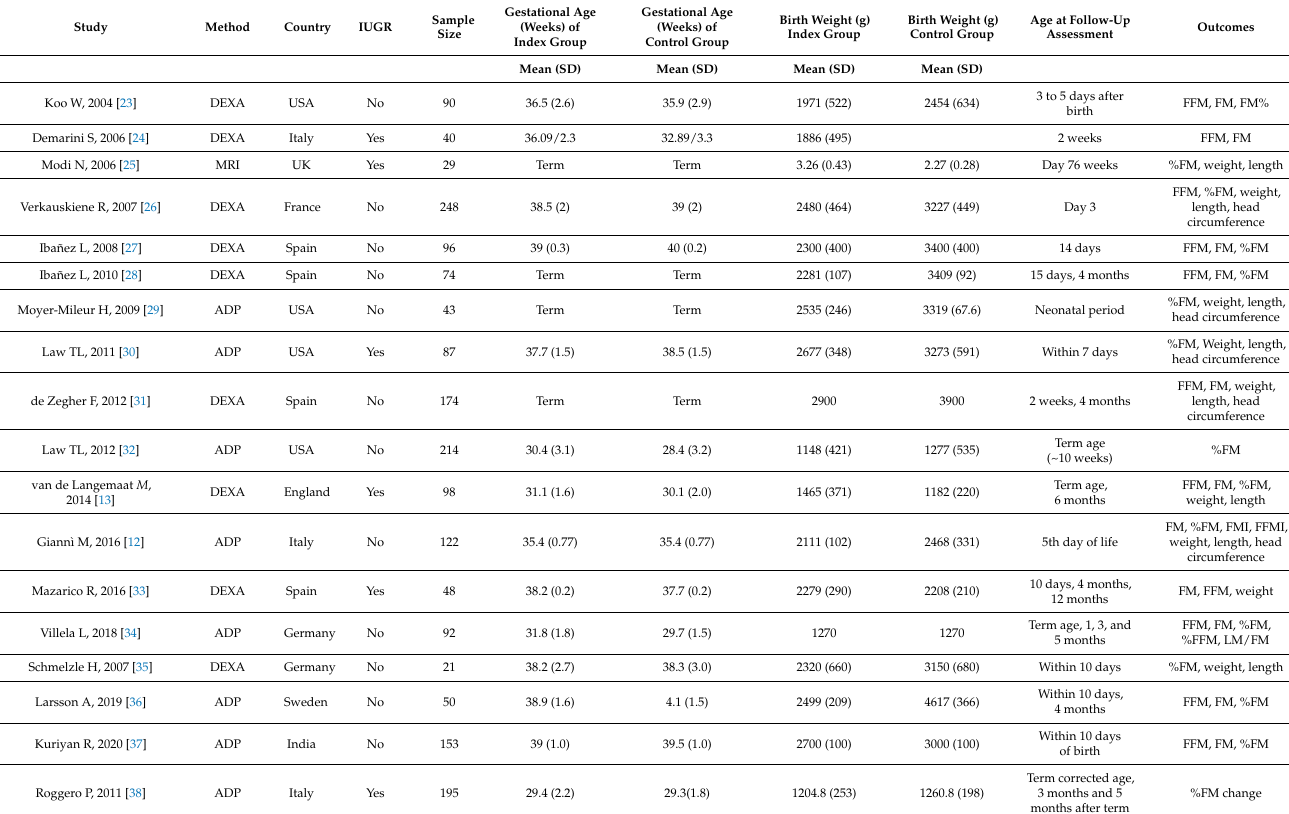
Table 1. Description of included